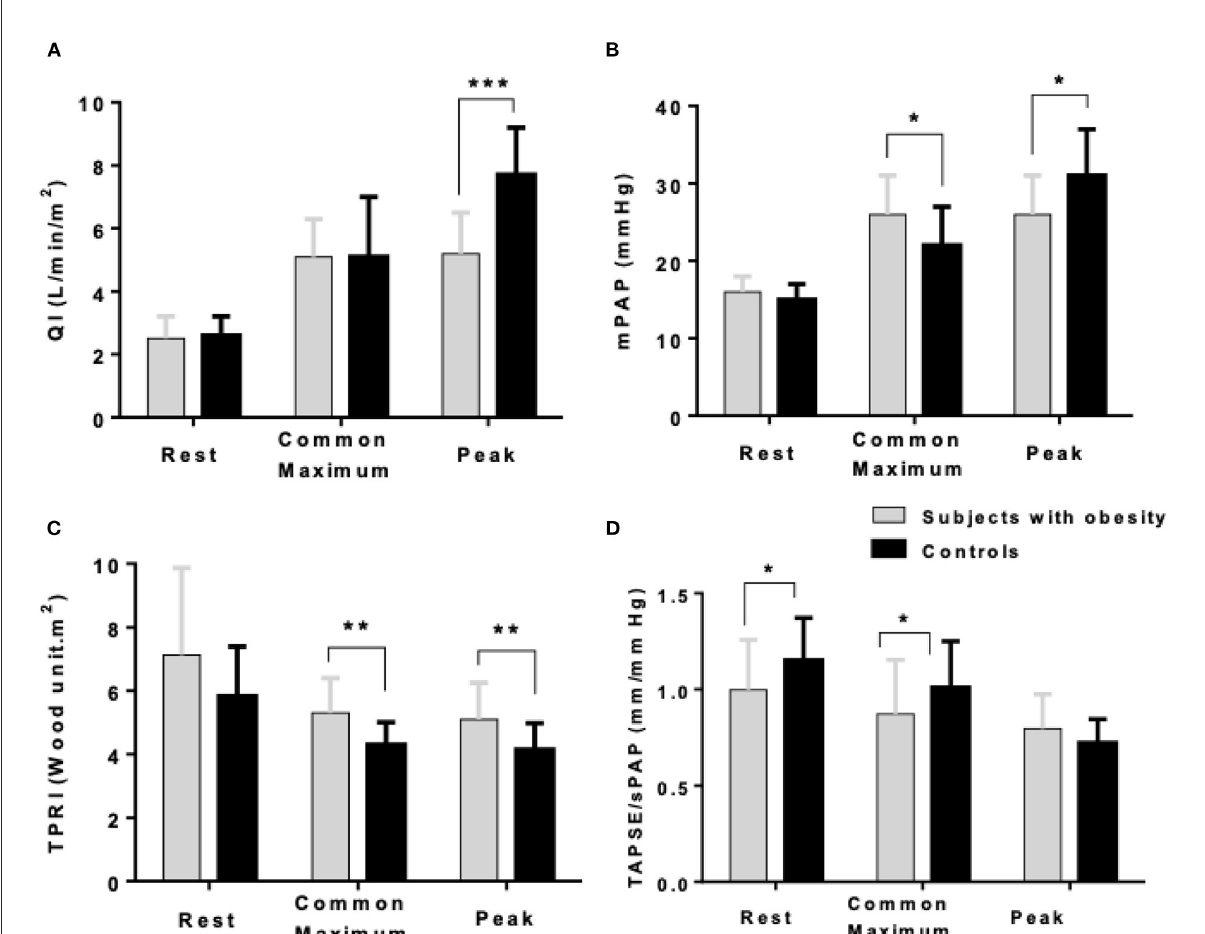
FIGURE1 Cardiac index (QI) (A) , mean pulmonary artery pressure (mPAP) (B) , indexed total pulmonary vascular resistance (TPRI) (C) , and the ratio of the tricuspid annular plane systolic excursion by the systolic pulmonary artery pressure (TAPSE/sPAP) (D) at rest, common maximum exercise